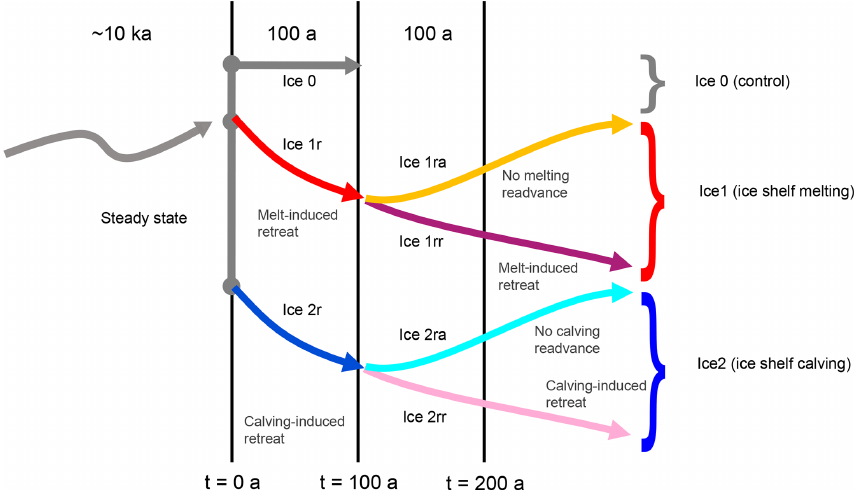
Figure 1. Relationship between the MISMIP+ Ice0, Ice1, and Ice2 experiments. An upward sloping curve indicates an advancing grounding line, a downward sloping curve a retreating grounding line. All three experiments start from a common steady state. The Ice0 experiment provides a control for the Ice1 and Ice2 experiments, which induce retreat with ice shelf melting or calving respectively for 100a. Later stages of the experiments remove or continue the melting or calving.